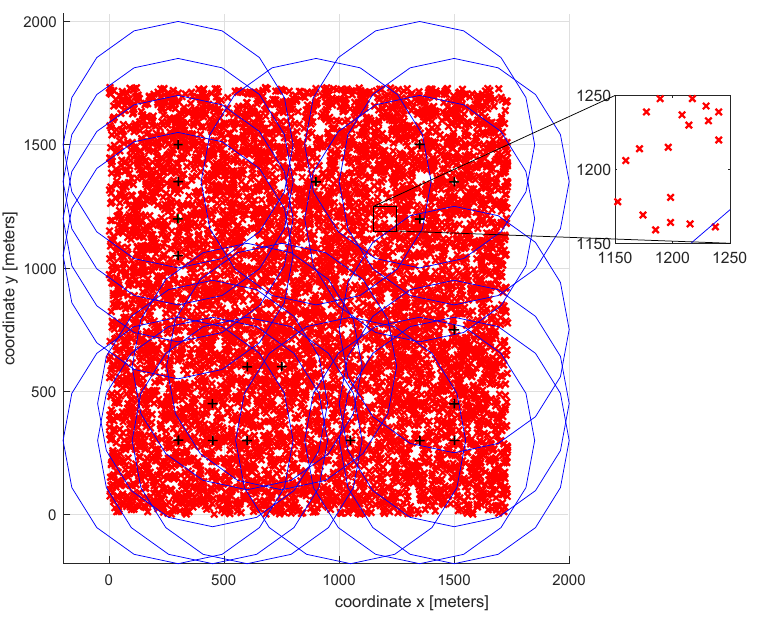
Figure 7. The final deployment solution for gNodeB on an urban area (red cross symbol represents user; black plus symbol represents gNodeB candidate location; and blue circle represents the gNodeB coverage